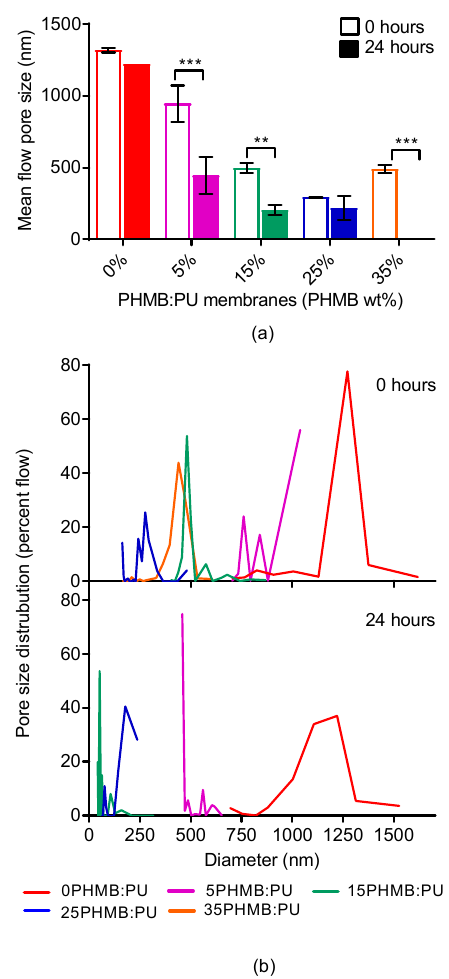
Figure5. Thee ff ectofincreasingPHMBconcentrationon poresize inPHMB:PUelectrospunmembranes. Figure 5. The effect of increasing PHMB concentration on pore size in PHMB:PU ( a ) Mean flow pore size (nm). Error bars describe the standard deviation from the mean, with n = electrospun membranes. ( a ) Mean flow pore size (nm). Error bars describe the standard 20–114. * signifies a significant percentage change after immersing samples in PBS (** for p < 0.001; deviation from the mean, with n = 20–114. * signifies a significant percentage change after *** for p < 0.0001). ( b ) Representative pore size distributions (percentage flow of N2) after a 0-h and immersing samples in PBS (** for p < 0.001; *** for p < 0.0001). ( b ) Representative pore size 24-h immersion in PBS. 35PHMB:PU membranes were not included in ( b ), 24 h, as they were recorded distributions (percentage flow of N2) after a 0-hour and 24-hour immersion in PBS. as